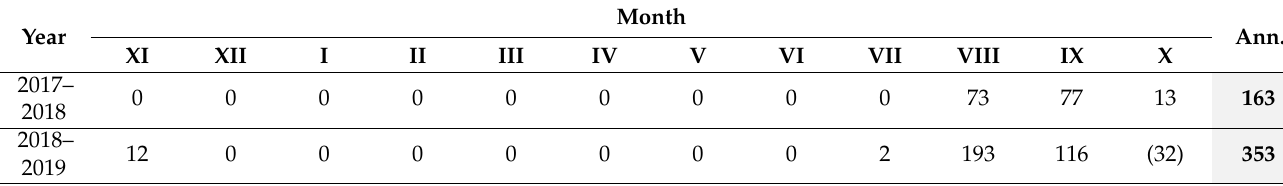
Table 10. Sums of positive daily temperatures at Banski suhodol